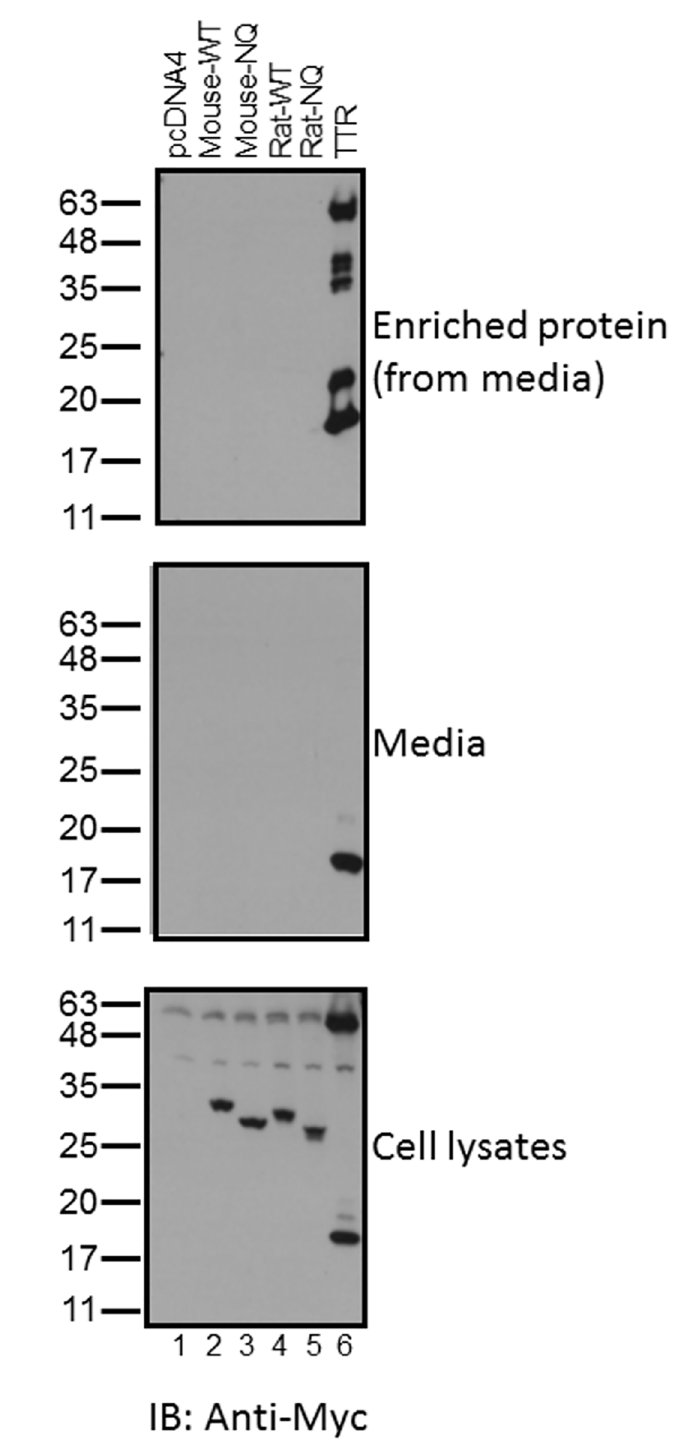
Fig 2. Murine and rat IGSF1-2 proteins are not secreted from transfected cells. HEK293cells were transfected with expressionplasmidsfor wild-type(WT) or glycosylation mutant (NQ) forms of murine or rat IGSF1-2, murinetransthyretin (TTR), or empty vector (pcDNA4). Note, in all cases, proteins were expressed with Myc/His tags at their C-termini. Media (top two panels) and wholecell protein lysates (bottom panel)were collectedand analyzedby SDS-PAGE and immunoblotting for Myc. In the middlepanel, proteins in culture